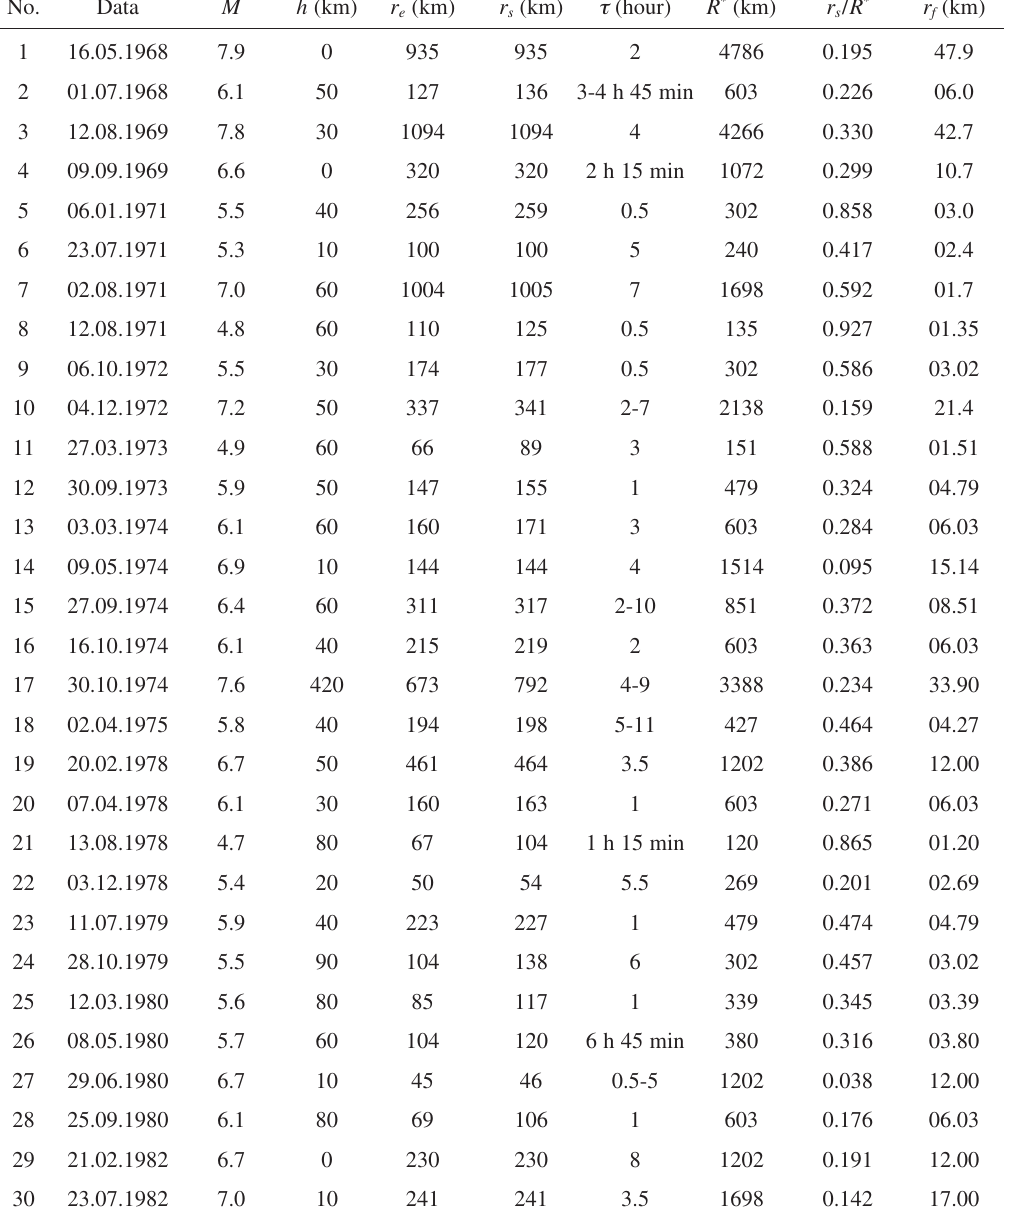
Table I. 30 earthquakes that were preceded by preseismic resistivity variations (Rikitake and Yamazaki, 1985) and their calculated parameters. Note: M – magnitude; h – depth; r e – epicentral distance; r s – hypocentral dis- tance; τ – precursor duration; R * – maximum size (radius) of the preparation zone; r f – characteristic size (ra- dius) of the focal zone; r s / R * – normalized hypocentral distance.